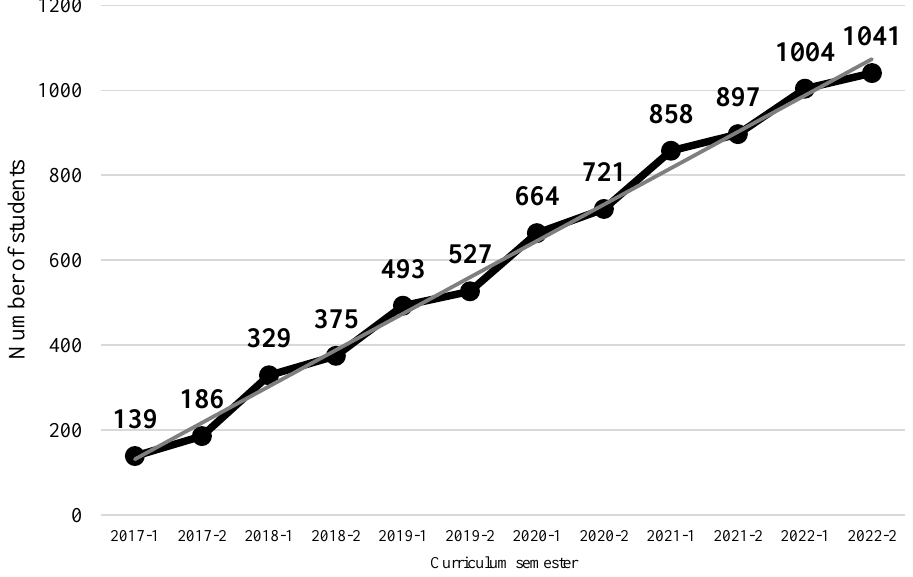
Figure 4. The number of students per semester within the civil engineering program.